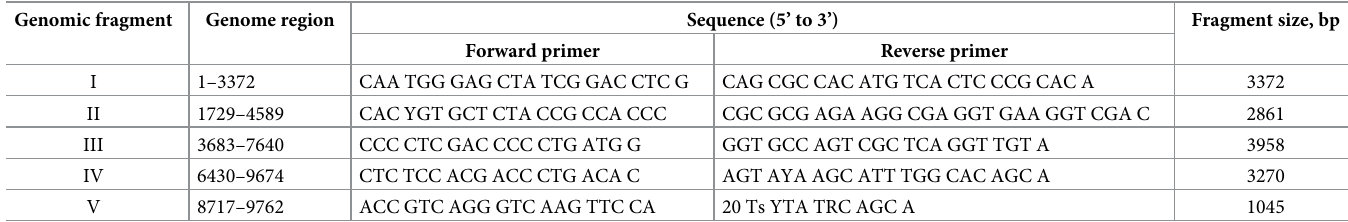
Table 4. Primers used for amplification of whole genomes of